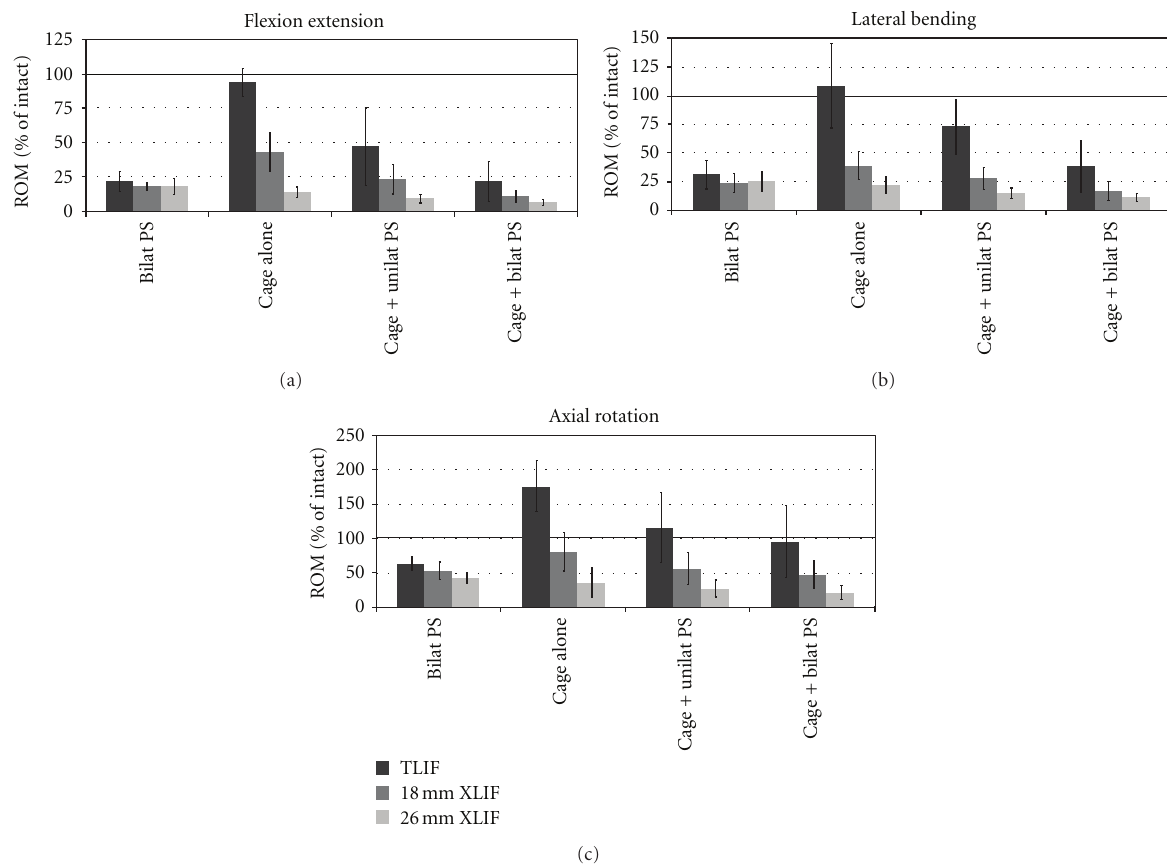
Figure 3: Range of motion (ROM) results normalized to intact motion: (a) flexion extension, (b) lateral bending, and (c) axial rotation. Bars represent means ± 1 standard deviation. Intact spine ROM (100%) indicated by solid